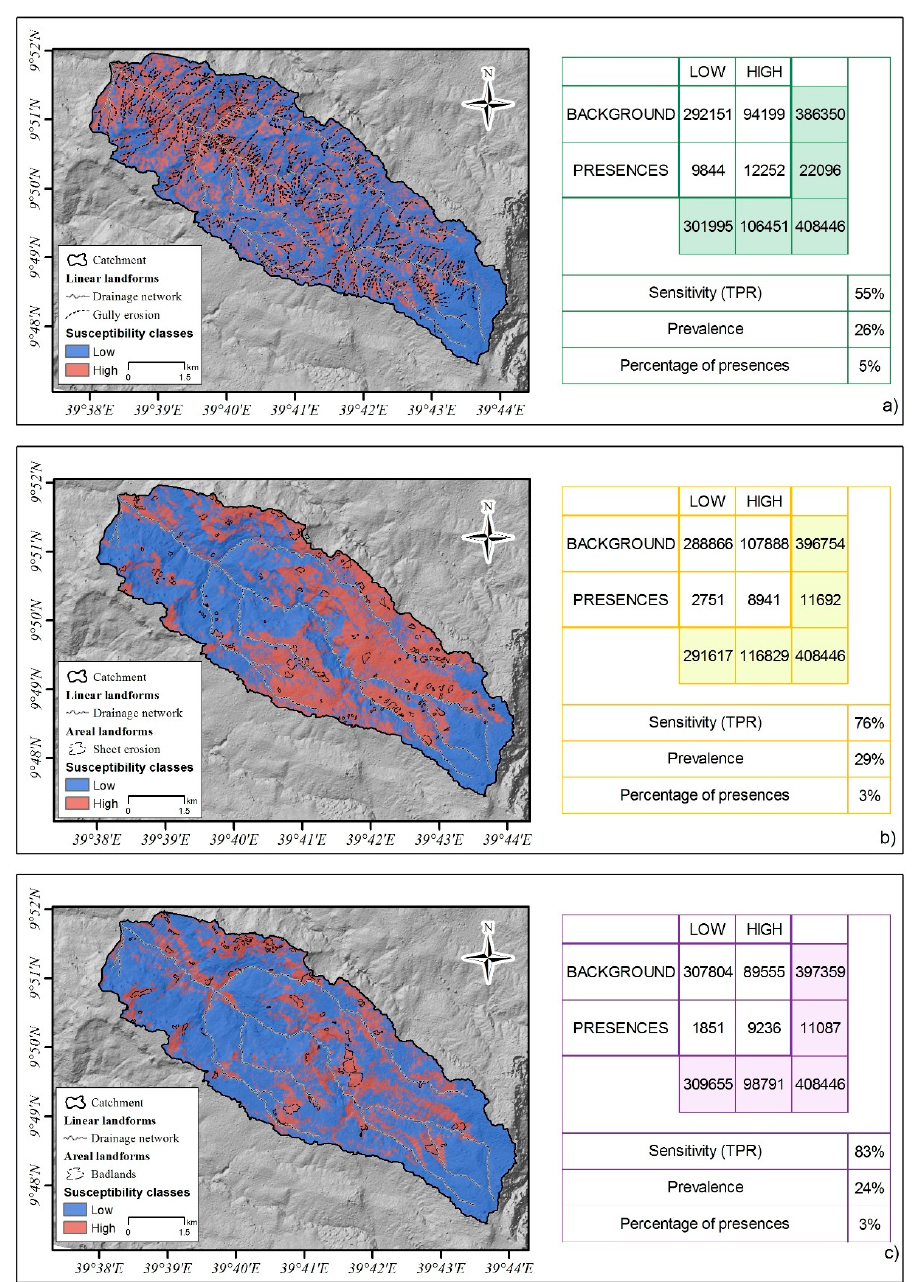
Figure 7. Binarized susceptibility maps, contingency tables, and threshold dependent indexes of performances: ( a ) Gully erosion; ( b ) Sheet erosion; ( c ) Badlands.